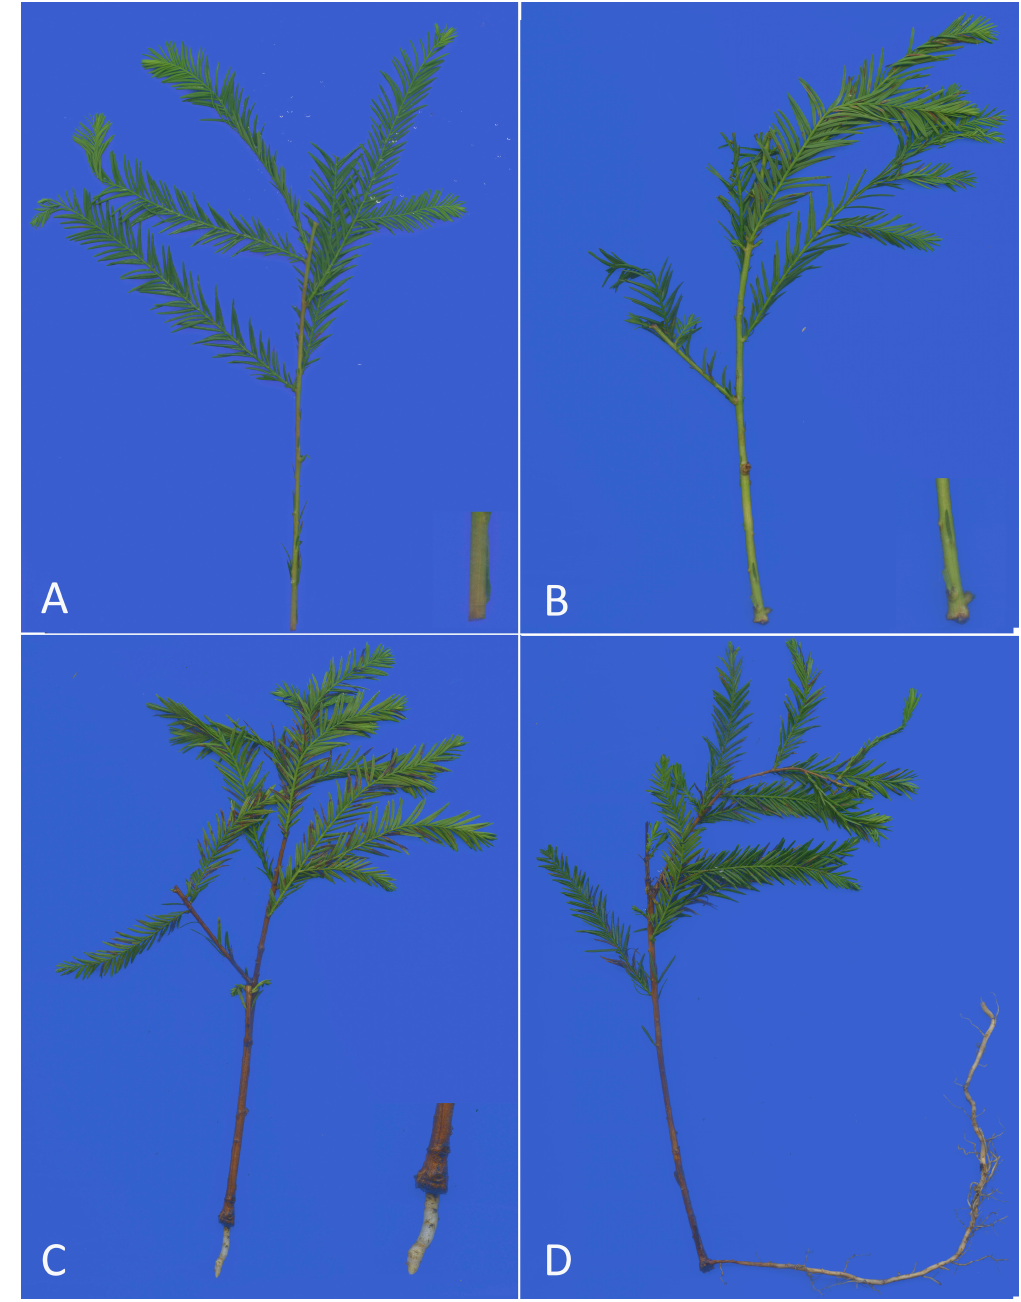
Figure 1. Adventitious root formation in Taxodium hybrid ‘Zhongshanshan 406’ at different developmental time points: ( A ) the control time point (S0); ( B ) the initial formation of callus (S1); ( C ) the formation of primary root (S2); and ( D ) lateral root systems (S3).